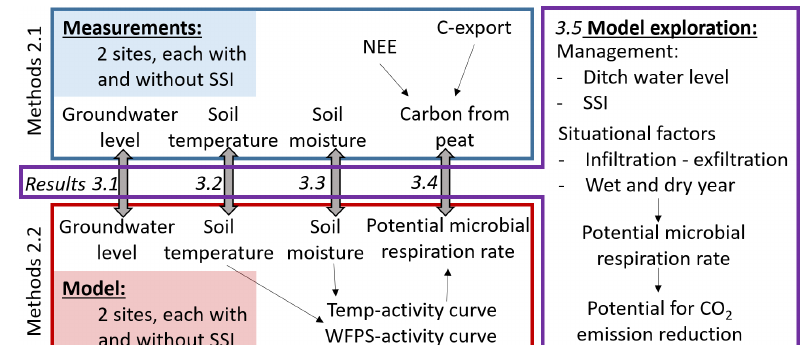
Figure 1. An overview of the research